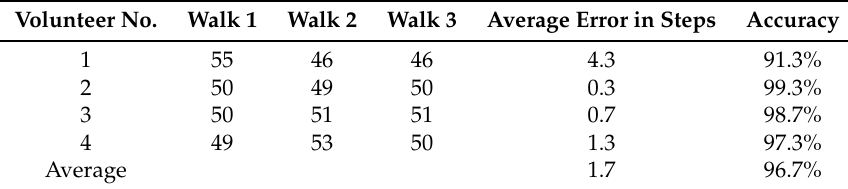
Table 18. Step detection using a Motorola smartphone with higher threshold.